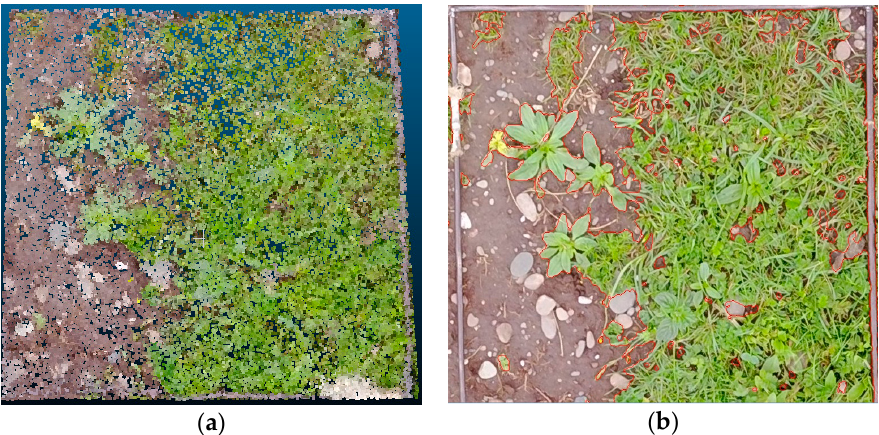
Figure 6. The point clouds of a frame in one quadrat in the Gansu study site ( a ); and the corresponding vegetation extraction result ( b ).